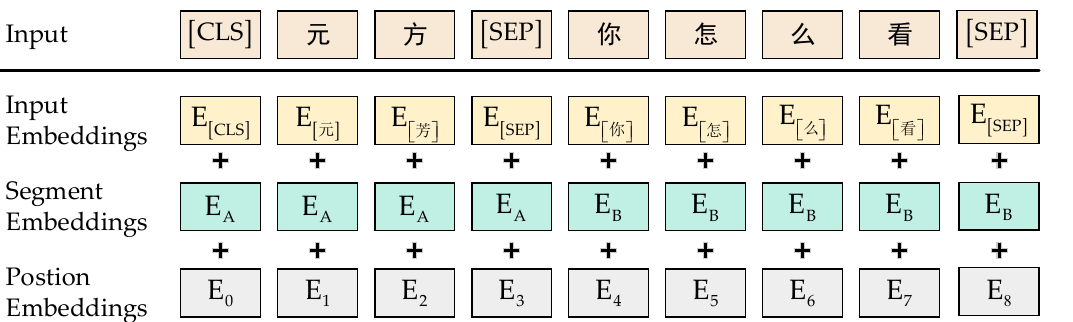
Figure 3. Input characterization diagram of BERT. (The intput ” 元芳，你怎么看 ” is translated as “Yuan Fang, what do you think”.)